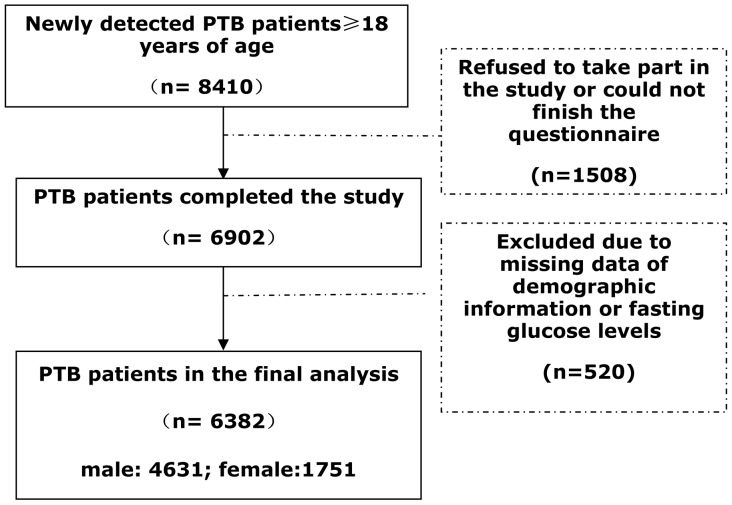
Flowchart of the pulmonary tuberculosis patients in the study, Linyi, 2010–2012.The details on the total number of eligible participants, those who have given written consent to undergo screening of DM and the patients included in the final analysis are illustrated in Figure 1. There were 8410 newly detected pulmonary tuberculosis patients in total study period. Finally, 6382 patients were included in the final analysis.